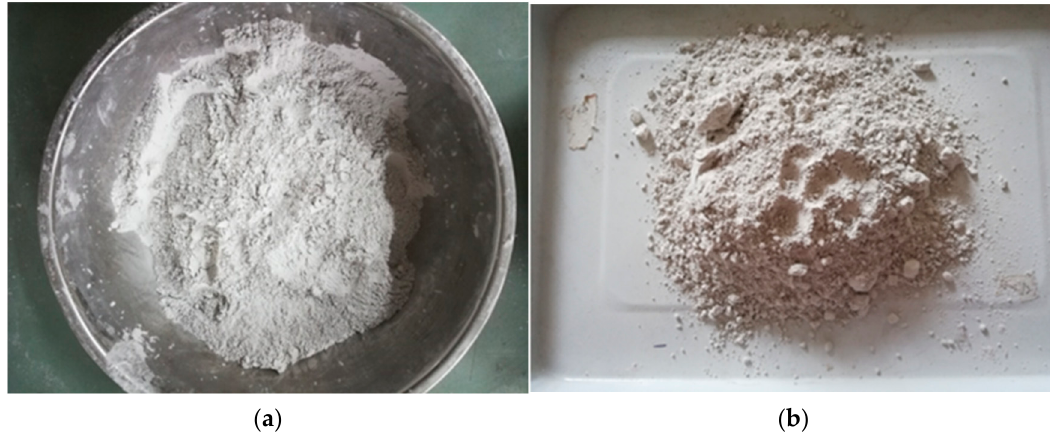
Figure 15. Raw materials. ( a ) UCCG ( b ) GGBFS powder.